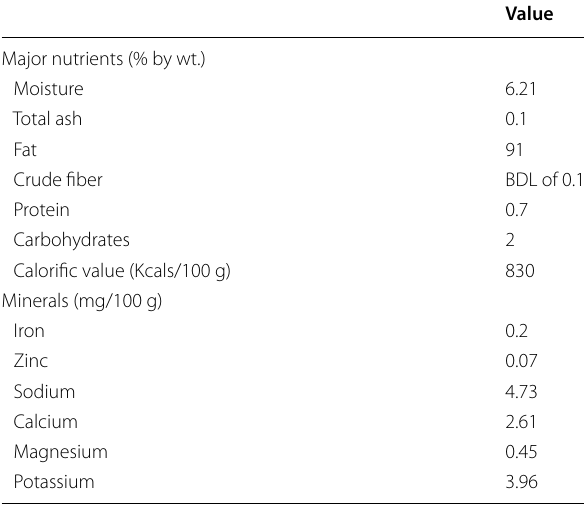
BDL below detection